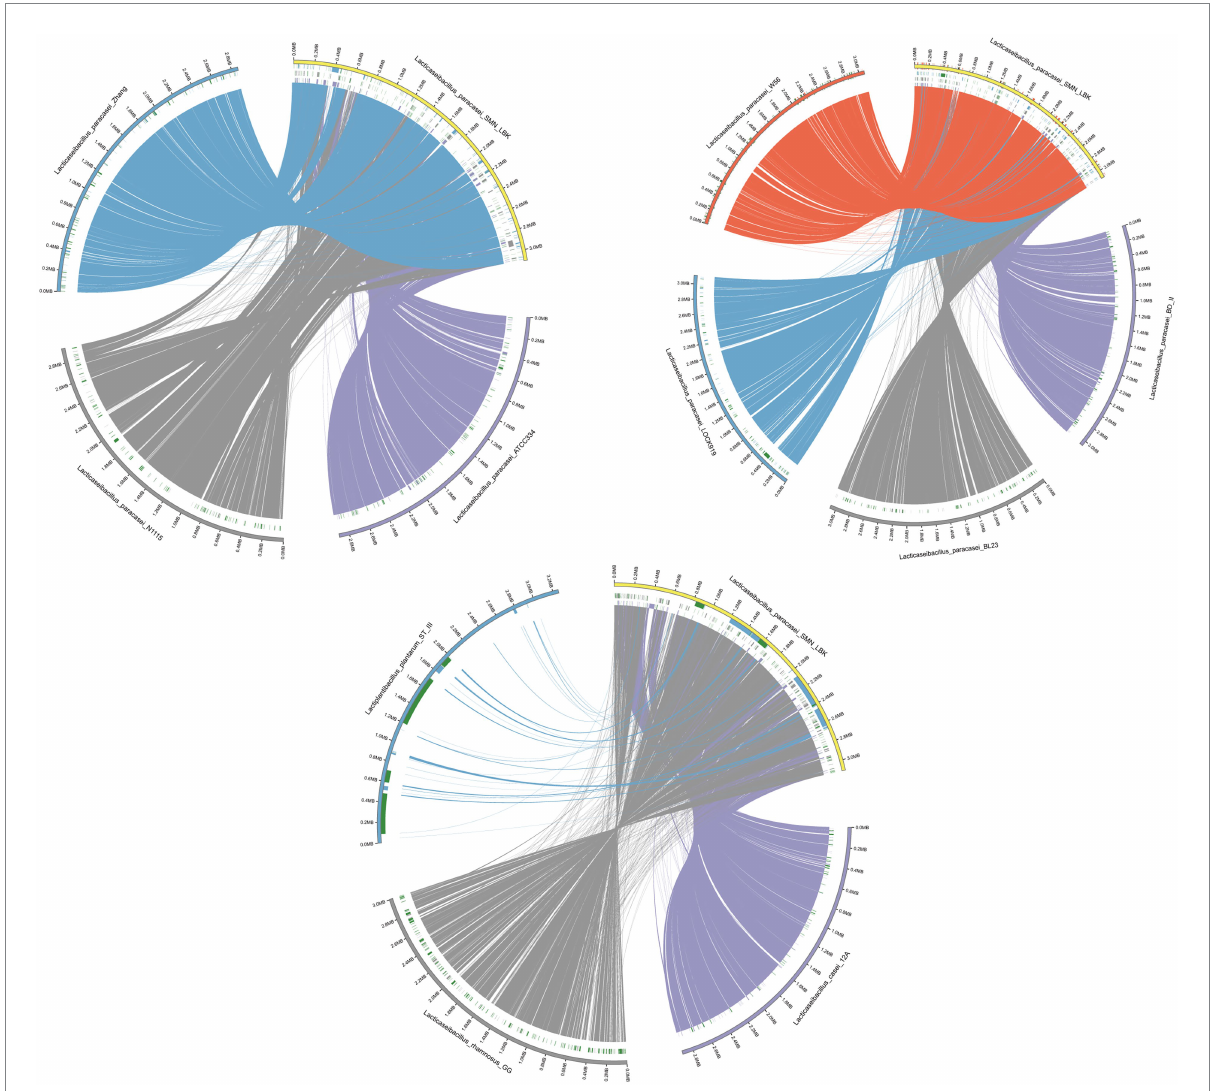
FIGURE 2 Circos collinearity plot of L. paracasei SMN-LBK and ATCC334, BD-II, BL23, W56, Zhang, LOCK919, and N1115. Different colors in the outer circle represent different samples, the reference genome is marked in yellow, the left side is the sample information, and the scale represents the genome scale. The color of the inner circle is the same as that of the outer circle, and the genomes of other strains are connected with the reference genome by lines of corresponding colors. Deletion of the genomes of other strains relative to the reference genome is shown in blocks of corresponding colors. All green blocks indicate insertions in the sample relative to the reference genome (only insertion-deletions longer than 10,000 bp are